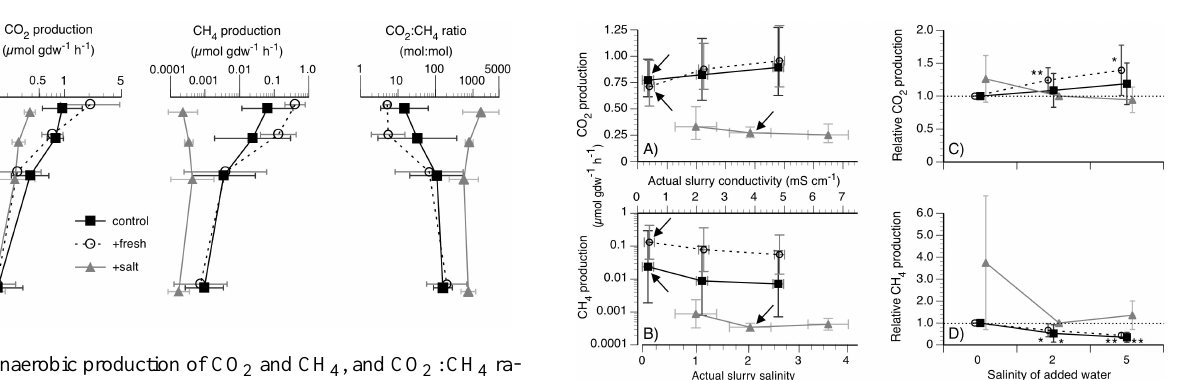
Fig. 1. Anaerobic production of CO 2 and CH 4 , and CO 2 :CH 4 ra- tios, at field salinities (i.e., salinity of slurry water = 0 for control and + fresh soils, 2 for + salt soils). Values for the control treatment are plotted at the midpoint of each depth interval, with depths for the + fresh and + salt treatments jiggered by ± 0.5cm to reduce overlap of symbols and error bars. Values are means ± standard deviation, n = 5 plots per data point.